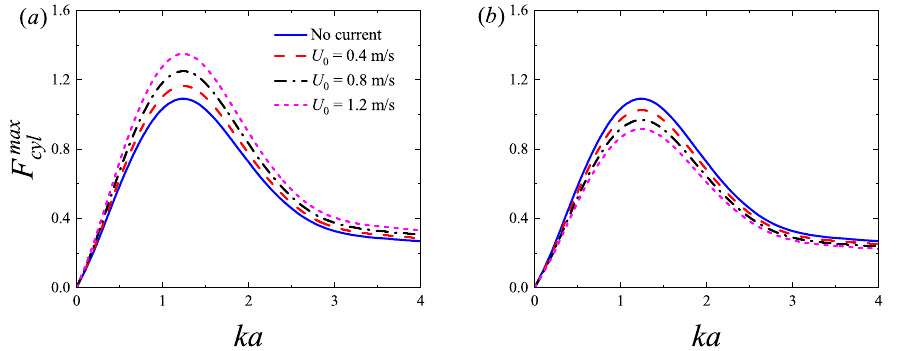
Figure 5. Variation of non-dimensional total wave force on the interior cylinder for different currrent speeds U 0 with a / b = 2, a / h = 1, k x / k = 0.5, β = π /3, G = 1, α = 2 π /3, and γ = 2 π /3: ( a ) | β − χ | = 0; ( b ) | β − χ | = π .